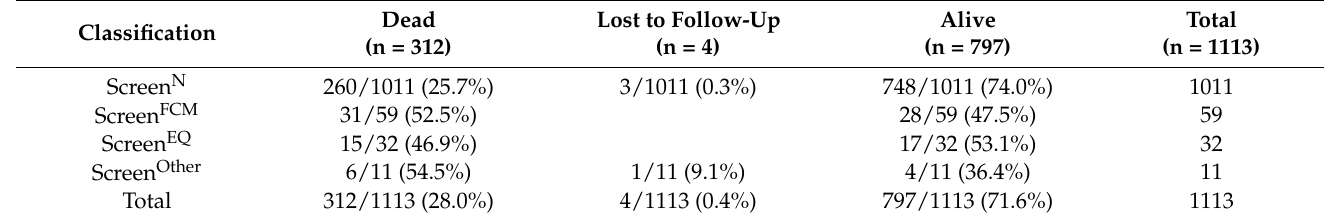
Table 2. Distribution of the number of cats alive, dead, or lost to follow-up at the time of the questionnaire by breed-screen classification for the total study population.